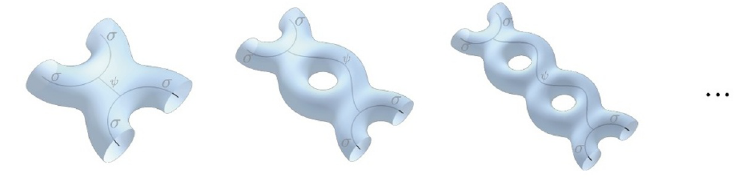
Figure 10 . Local con(cid:12)gurations of fusion diagrams with some of the w i labels taking the value states in this case are of the form jf a